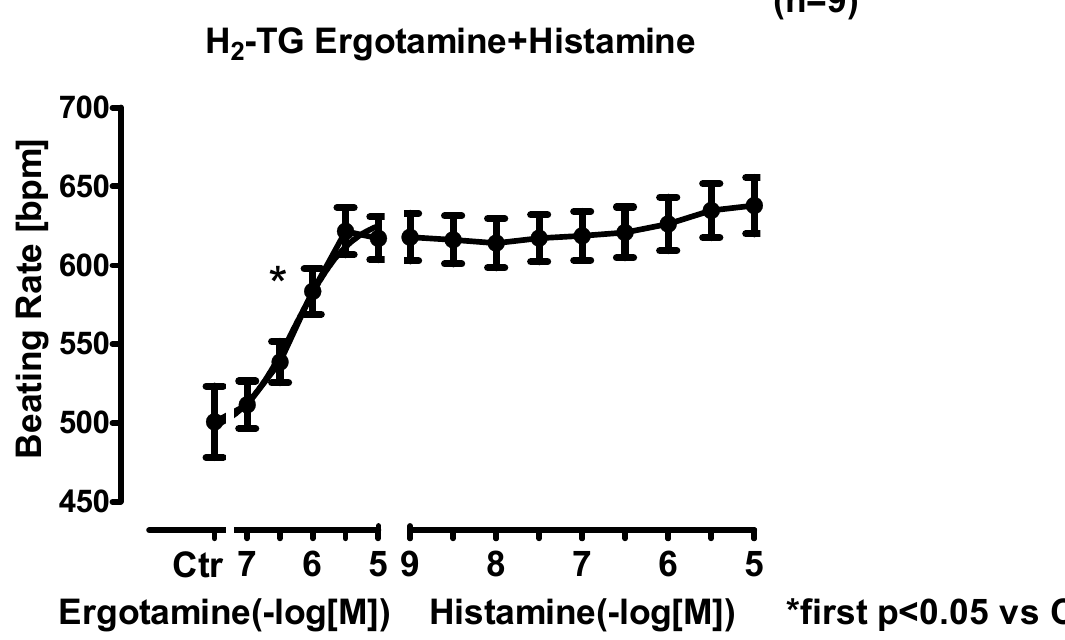
Figure 3. Ergotamine increases frequency in H 2 -TG: ( A ) Original recording of beating rate in H 2 -TG right atrium. Original recording: effect of ergotamine and histamine on beating rate in spontaneously beating right atrial preparations from H 2 -TG. The blue lines indicate duration of transient arrhythmias. Blue triangle mean addition of ergotamine and black triangles indicate addition of histamine. ( A ). Summarized effect of ergotamine and histamine on beating rate in spontaneously beating right atrial preparations from H 2 -TG ( B ). Ordinate in ( A ): beating rate in beats per minute (bpm). Ordinate in ( B ) in beating rate in beats pro minute (bpm). Abscissae in in ( A , B ), of ergotamine or histamine in negative decadic logarithms of molar concentrations. Horizontal bar in A indicates time axis in minutes (min). First significant differences versus control (Ctr; pre-drug value) are indicated by asterisks. “n” indicates number of experiments.